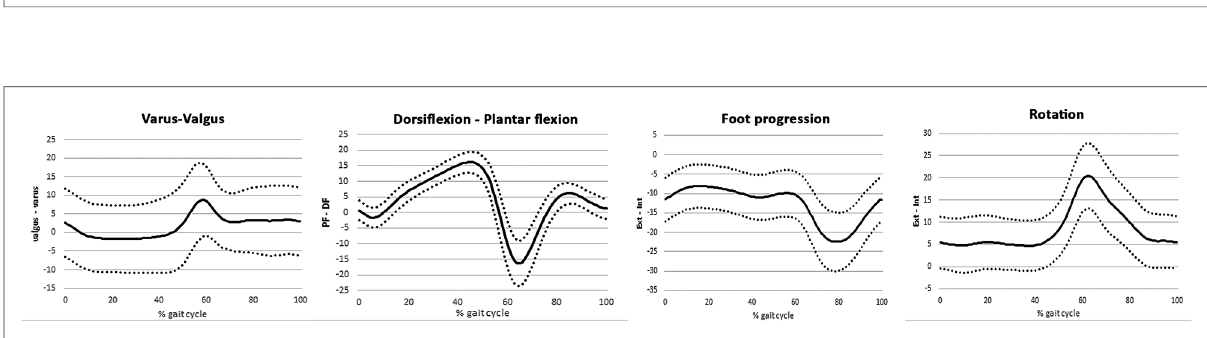
FIGURE 3 Ankle kinematic curves (degree) during gait cycle from our reference, mean (solid line) and standard deviation (dotted line), PF=plantar fl exion, DF= dorsi fl exion, Ext=external rotation, and Int=internal